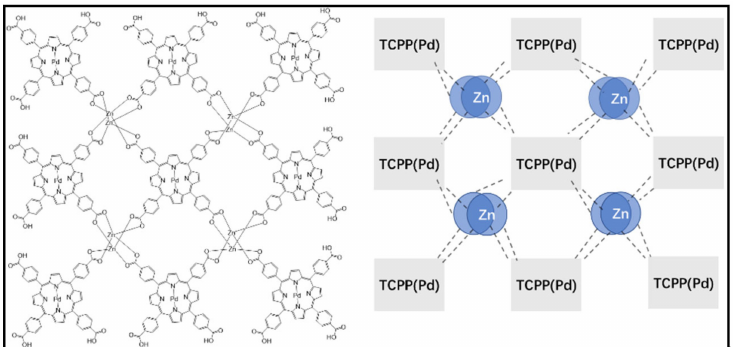
Figure 3. The proposed molecular structure of the prepared Zn–TCPP(Pd) MOF nanosheets.